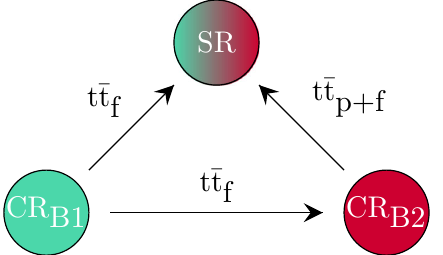
Fig. 3 Strategy for the background estimation in category B. The tt f backgroundinthesignalregionisderivedfromthecontrolregionCR B1 . The tt p + f background in the signal region is derived from the